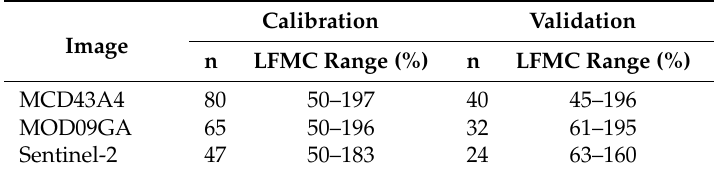
Figure 3. Comparison of the temperature regime (average maximum, mean and minimum values) and precipitation distribution between years during the study period. Table 2. Sample size (n) and the range of LFMC field values available in model calibration and validation datasets for each surface reflectance